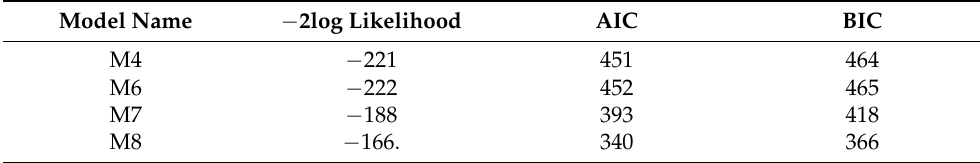
Table 8. AIC, BIC, and -2log likelihood values of different models.